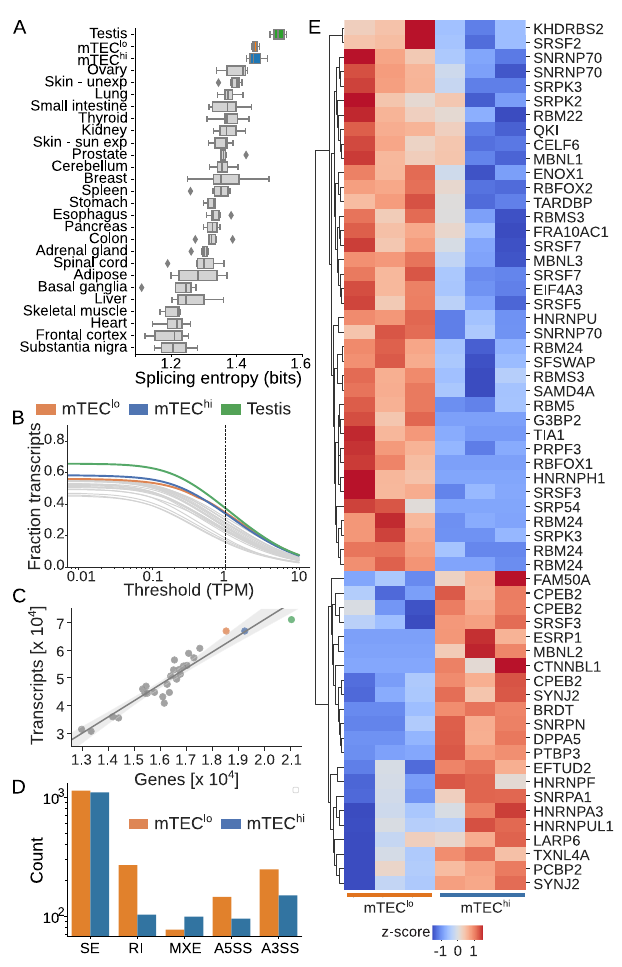
Fig. 5 Alternative splicing in mTECs is mediated by differential expression of peripheral splicing factors. A Splicing entropy calculated for mTEC hi and mTEC lo as well as 25 healthy peripheral tissue samples from GTEx 47 . Boxplots show median (central line) with interquartile range (IQR, box) and extrema (whiskers at 1.5× IQR). Outliers beyond 1.5× IQR are shown as dots. B Fraction of transcriptome expressed at varying transcript per million (TPM) thresholds for mTEC and peripheral tissue samples. C Linear regression fi tting the number of expressed transcripts as a function of the number of expressed genes in healthy GTEx samples predicts number of transcripts in mTEC hi and mTEC lo samples. The gray shaded area marks the 95% con fi dence interval. D Differential splicing between the mTEC hi and mTEC lo populations as predicted by rMATS 65 divided by skipped exons (SE), retained introns (RI), alternative 5' and 3' splice sites (A5SS, A3SS), and mutually exclusive exons (MXE). E Clustermap showing row z -scored expression of known peripheral tissue splicing factor transcripts signi fi cantly ( q ≤ 0.05 by Wald test) enriched in either the mTEC lo (count = 38) or mTEC hi (count = 22) population. All panels: n = 5 paired mTEC samples, n = 6 samples per GTEx tissue. Source data for A , C – E are provided in the Source Data fi